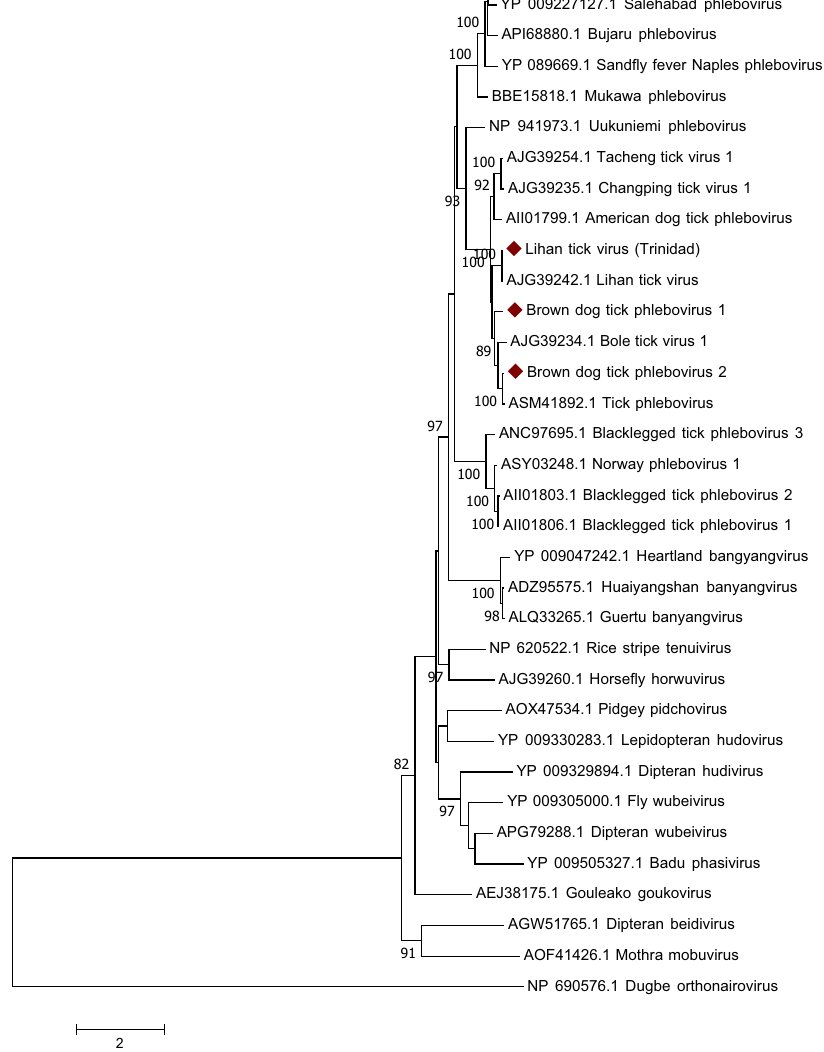
Figure 2. Phylogenetic relationships of Phenuiviridae based on a 483-aa fragment of the RdRp that includes the premotif through motif E of the conserved palm